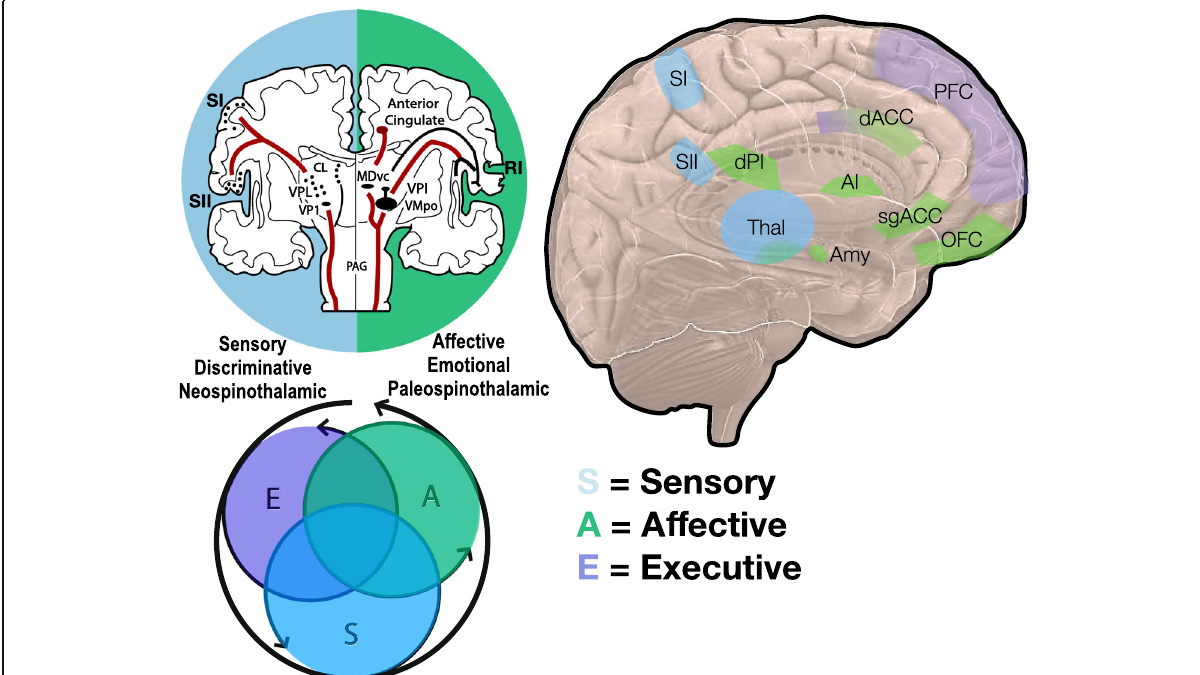
Fig. 8 Cortical and Sub-cortical Pain Processing. Sensory-discriminative pain processing with thalamus, SI, SII and posterior IC, with sensory discriminative pain relayed through the ventroposterior-lateral and ventroposterior-medial thalamic nuclei and is also termed the neospinothalamic pathway. Affective-emotional pain processing with dorsal ACC and Anterior IC while affective sensory information to the AEN is thought to be relayed through the medio-dorsal thalamus, also termed the paleospinothalamic pathway. PFC (Prefrontal Cortex), OFC (orbitofrontal cortex) SI (Primary Somatosensory Cortex) SII (Secondary Somatosensory Cortex) dACC (Dorsal Anterior Cingulate Cortex) Amy (Amygdala), AI (Anterior Insula), RI (Rostral Insula) dPI (Dorsoposterior Insula), PAG (Periaqueductal